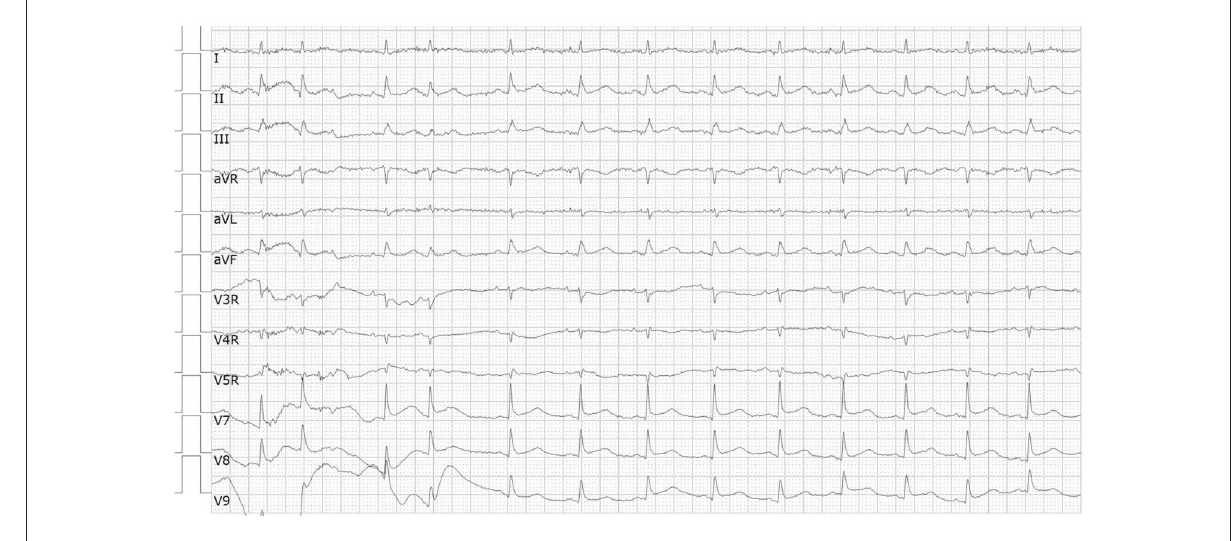
FIGURE3 ECG on admission showed ST-segment elevation in leads V7 through V9.